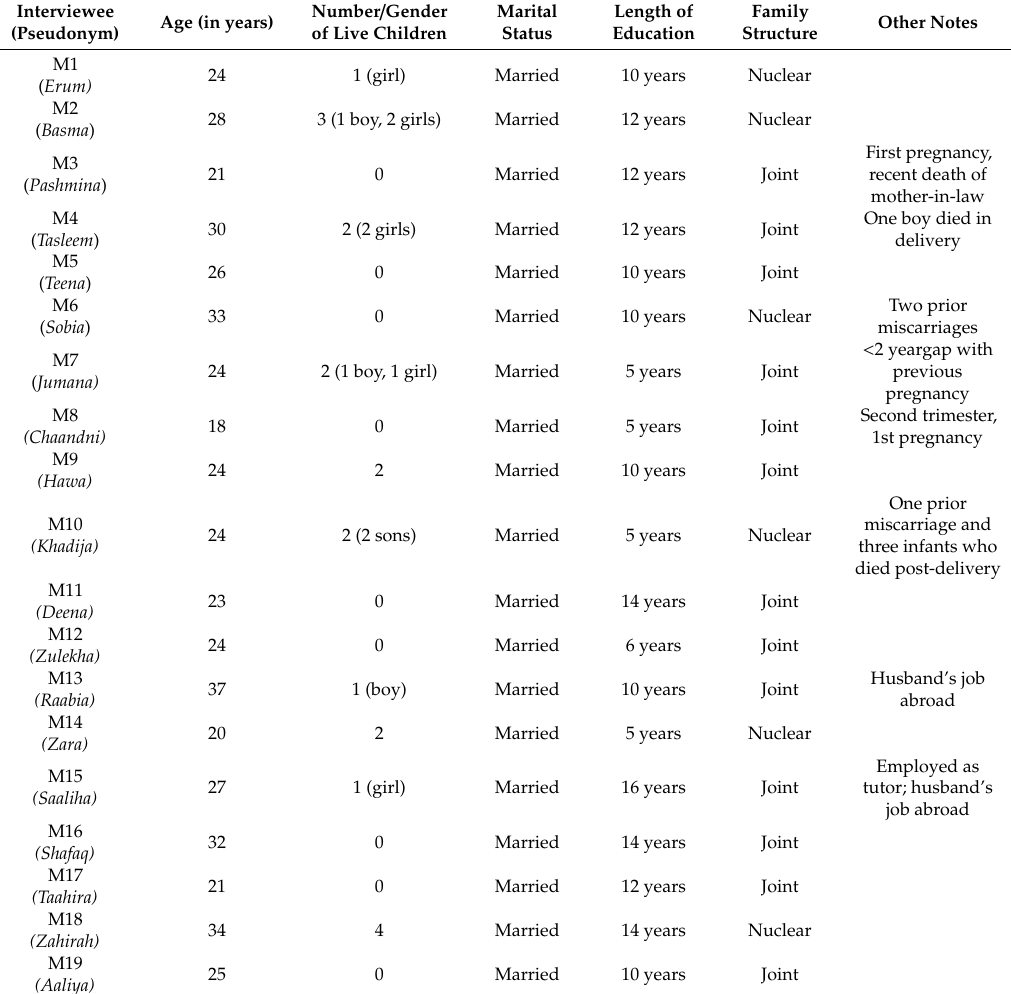
Table 2. Demographic Profile of Study Participants (n =